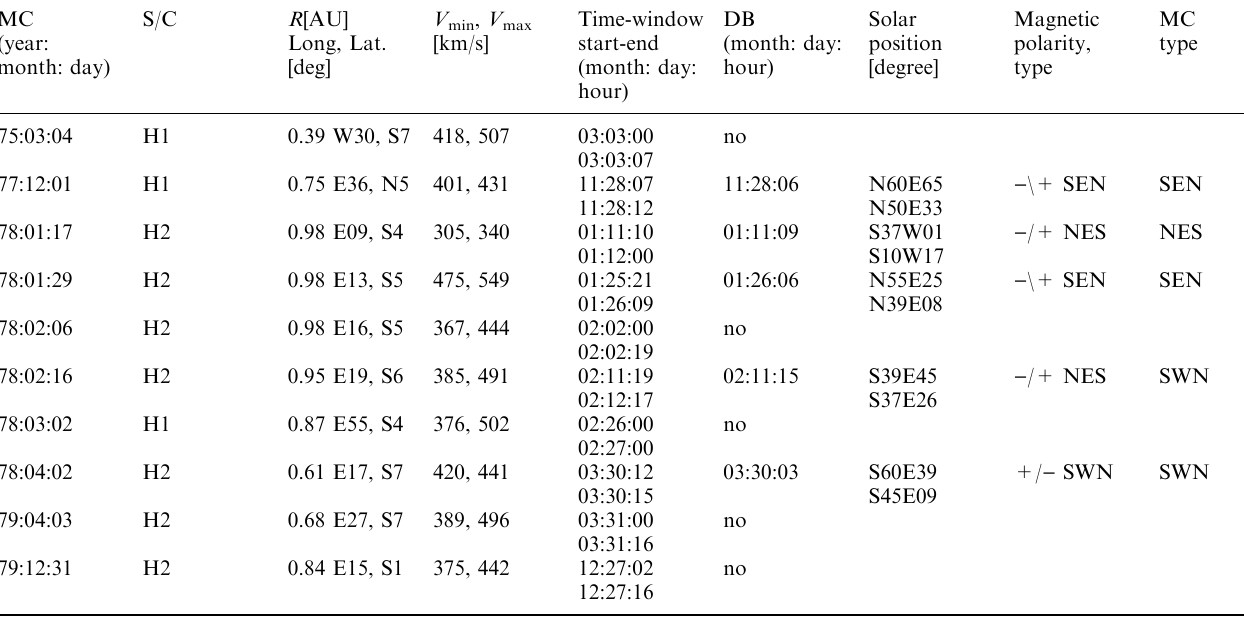
Table 4. Associations between MCs observed with Helios 1/2 and disappearing filaments (DBs). Left to right: date of the MC, s/c, s/c coordinates, minimum and maximum measured proton speeds inside the MC, calculated time-window for the solar event, disappearance of the DB at the Sun, solar position of the DB, magnetic polarity & inferred flux tube type of the DB, in-situ observed type of the MC (after Bothmer and Schwenn,